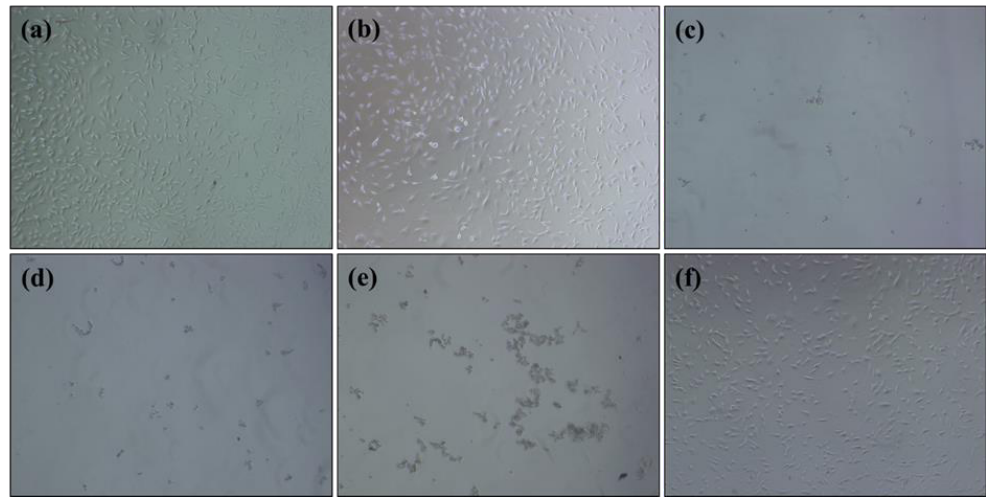
Figure 8. The toxicity evaluation of pure PAN nanofiber: ( a ), with one cycle AgNPs loaded: ( b ), with two cycles AgNPs loaded: ( c ), with three cycles AgNPs loaded: ( d ), positive control: ( e ), and negative control: ( f ).